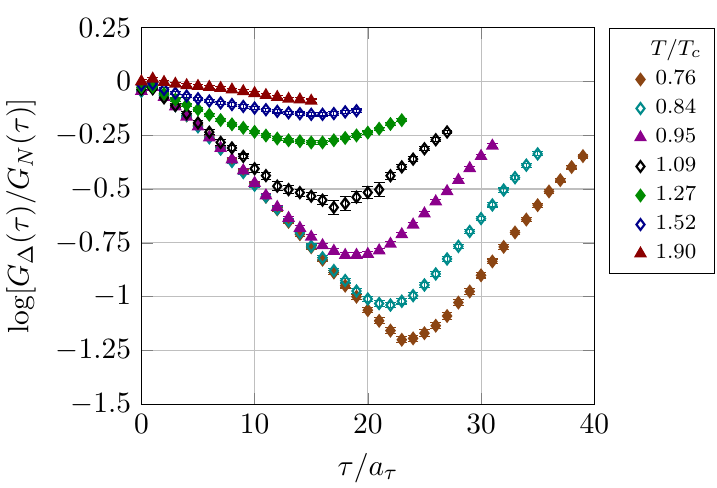
Figure 6 . Logarithm of the ratio between the (cid:1) and N correlators, G (cid:1) ( (cid:28) ) =G N ( (cid:28) ), for di(cid:11)erent temperatures, all normalised by G (cid:1) (0) =G N (0) at T=T c = 1 :